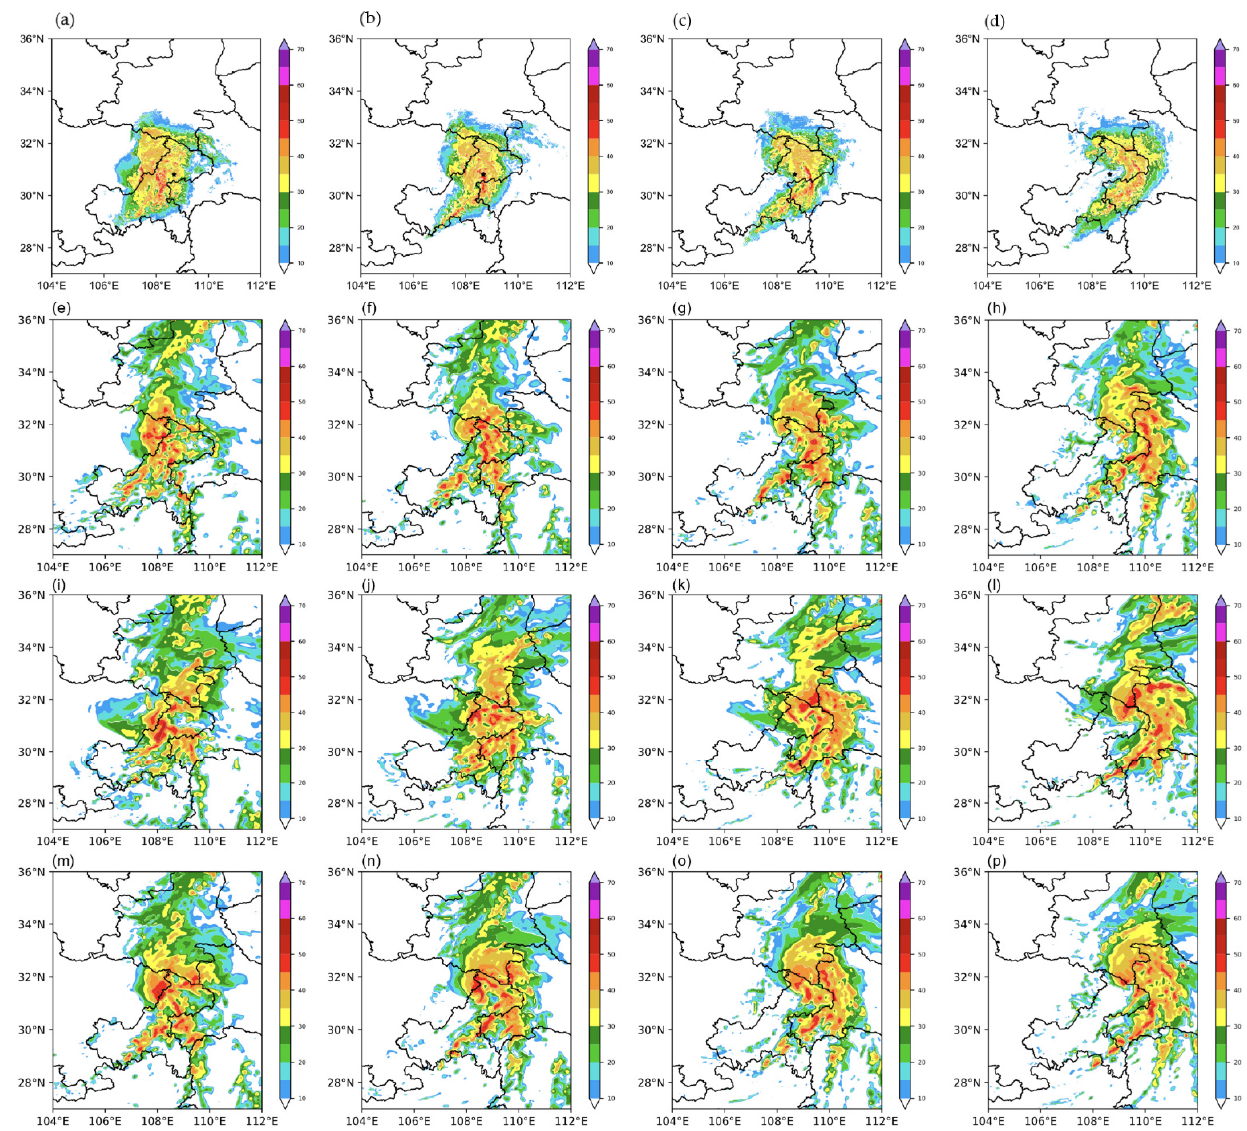
Figure 9. The same as Figure 8 but at 0100 UTC ( a , e , i , m ), 0200 UTC ( b , f , j , n ), 0300 UTC ( c , g , k , o ), and 0400UTC ( d , h , l , p ) 5 June 2019.